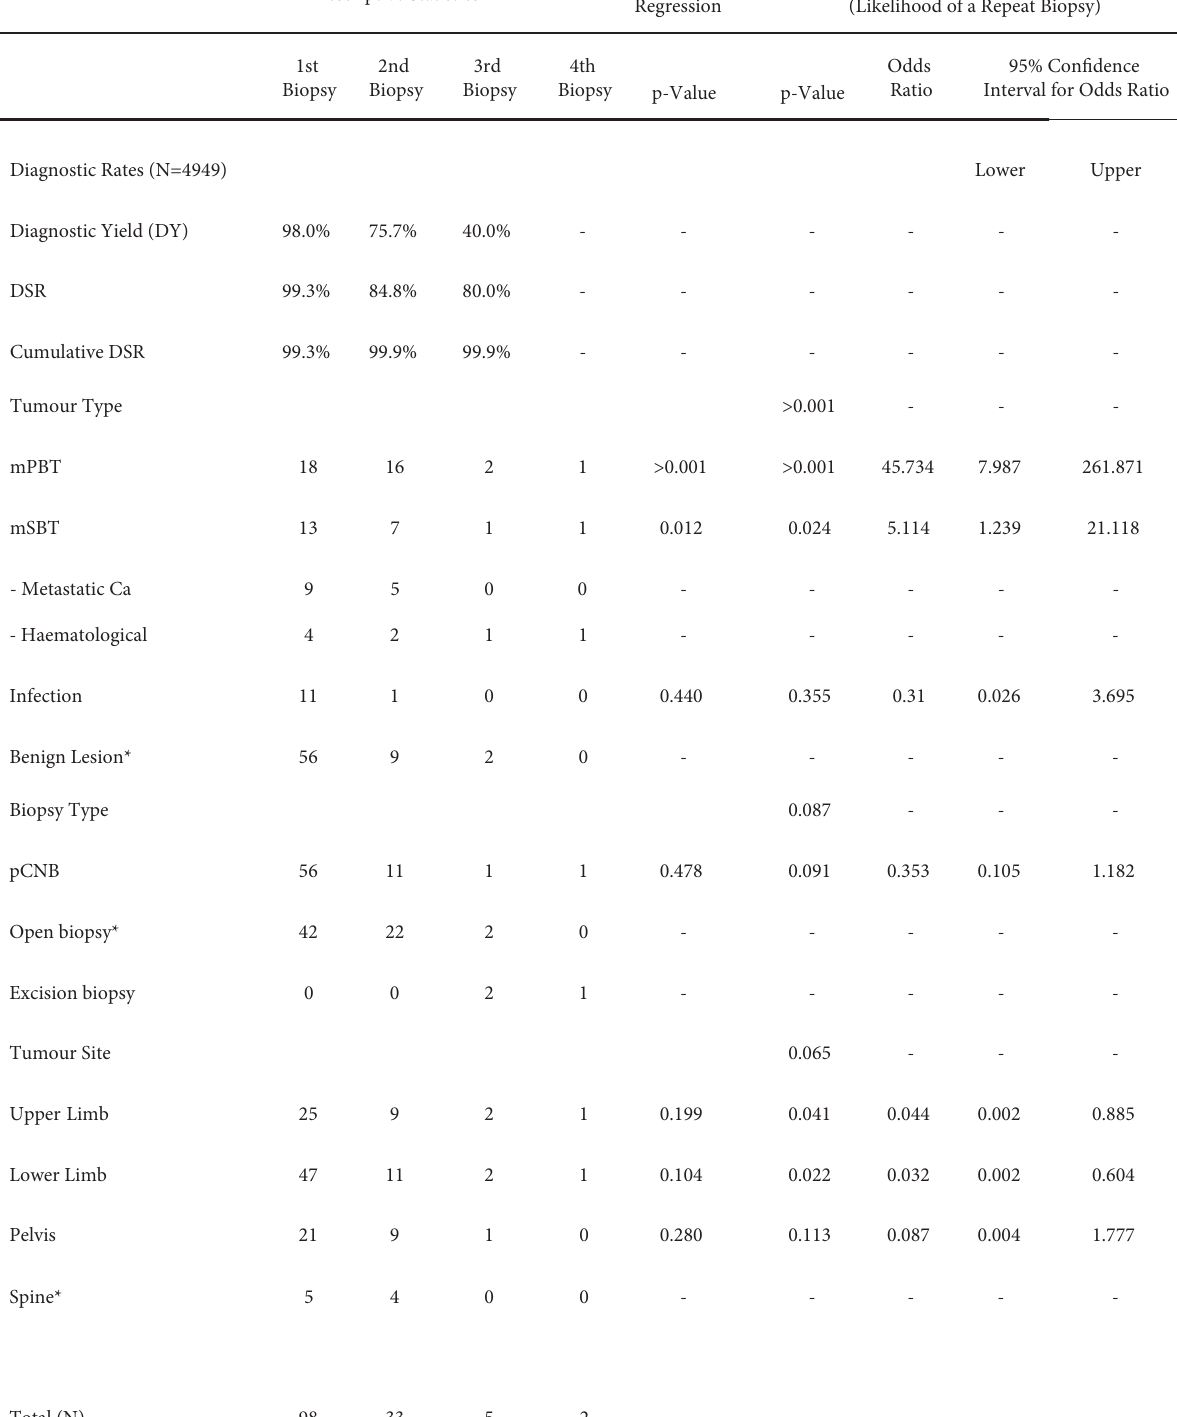
Figure 1: Results table: descriptive statistics including diagnostic rates and frequencies of biopsies grouped by tumour type, biopsy type, and tumours site for successive biopsies. The results of ordinal and multinomial logistic regression are shown on the right-hand columns. p values for groups represent the “main effect” of that group, and individual factors are represented with odds ratios, confidence intervals, and p values in relation to the reference category ( ∗ ). Pearson’s chi-square for “goodness of fit” was 80.0 ( p � 0 . 51) and 84.7 ( p � 0 . 083) for the multinomial regression and ordinal regression models, respectively. DSR � diagnostic success rate of the MDT, mPBT � malignant primary bone tumour, mSBT � malignant secondary bone tumour, and pCNB � percutaneous core needle